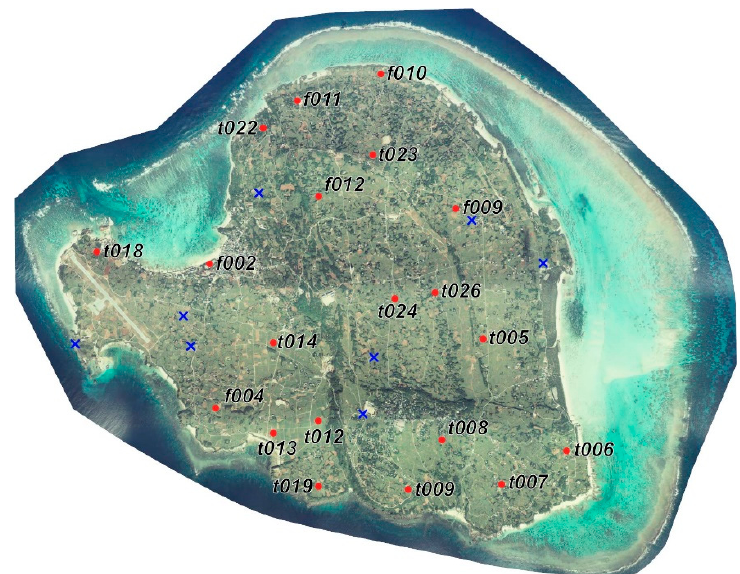
Figure 2. Orthophoto of the Yoron island exhibiting the Ground Control Points (GCP) location (red circle marks) and the assessment point altitudes (blue X marks).